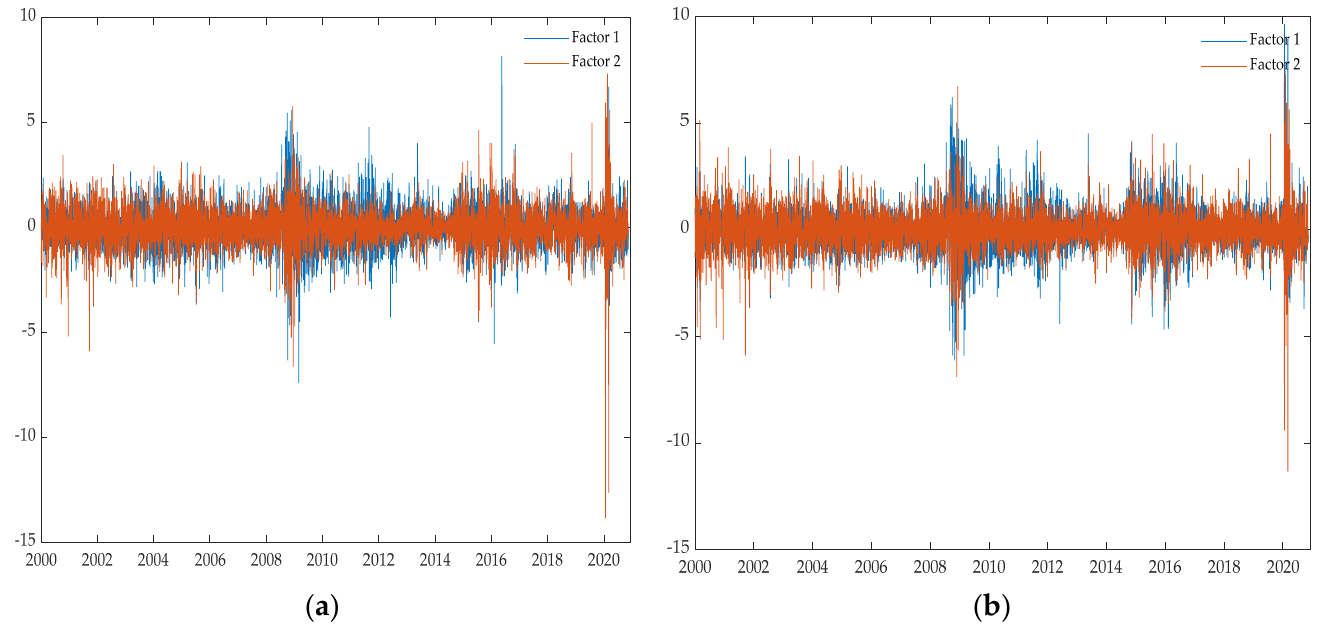
Figure 1. Scree plots. ( a ) Scree plot of oil-importing countries. ( b ) Scree plot of oil-exporting coun- tries.